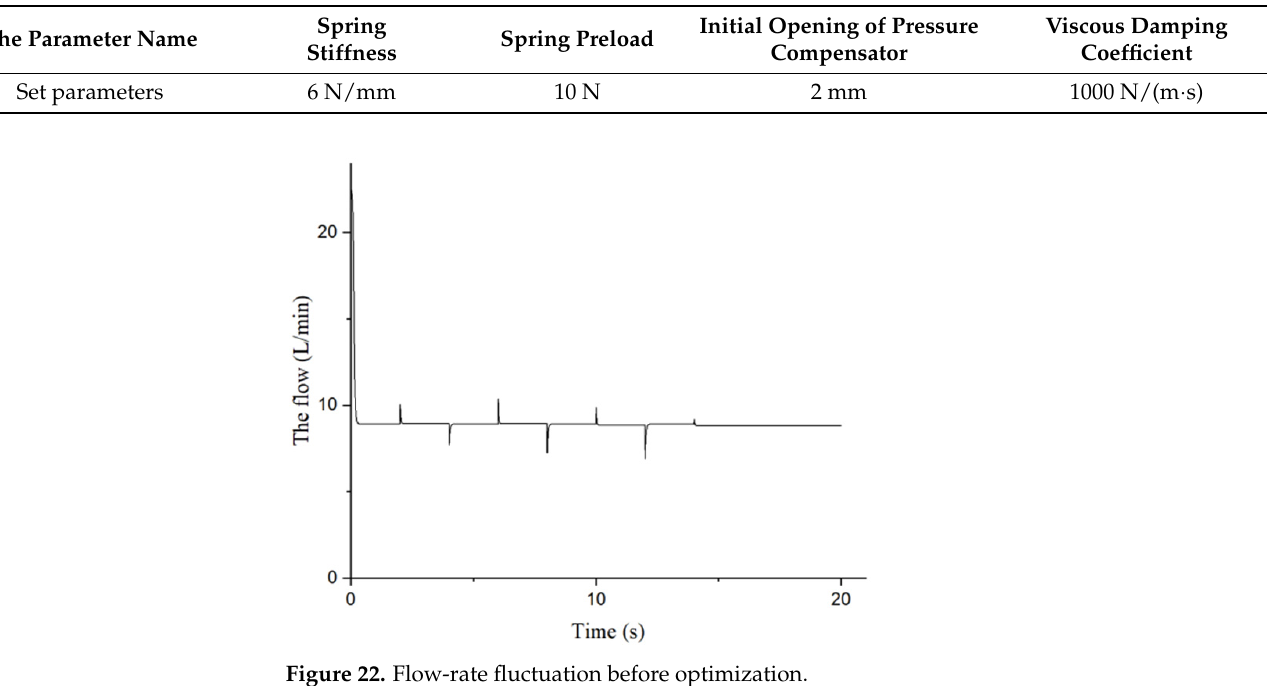
Figure 22. Flow-rate fluctuation before optimization. Table 3. Selection of parameters related to speed-regulating valve after